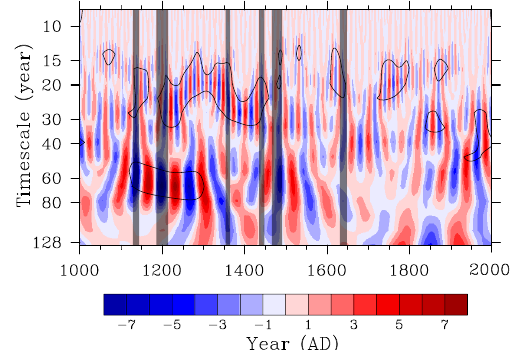
Figure 6. The real-part coefficients of wavelet transform of the sim- ulate precipitation series. The thick contour encloses regions with greater than 95% confidence of wavelet power. Six well-captured